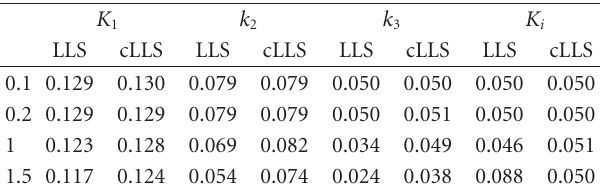
Table 2: Mean of estimated parameters for the simulation data at di ff erent noise levels (“true” parameter values: K 1 = 0.130, k 2 = 0.080, k 3 = 0.050, K i = 0.050).